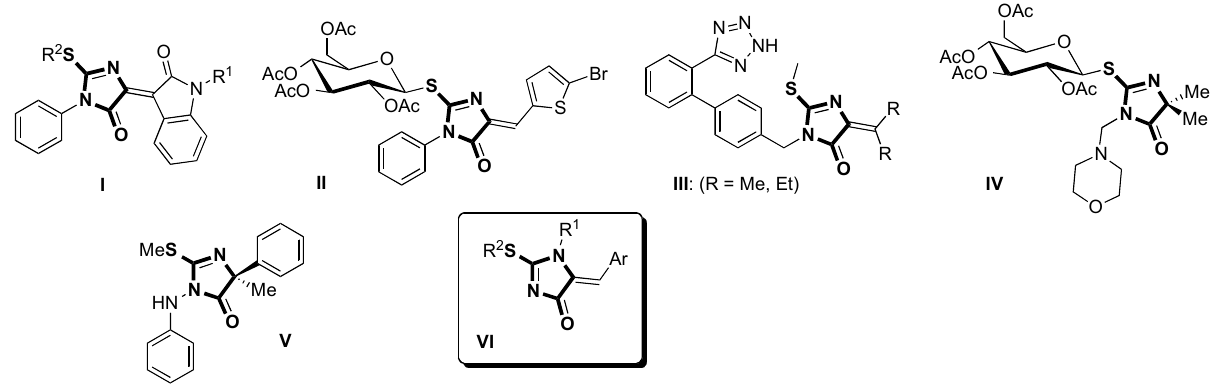
Figure 1. Select 3,5-dihydro-4 H -imidazol-4-one derivatives with biological